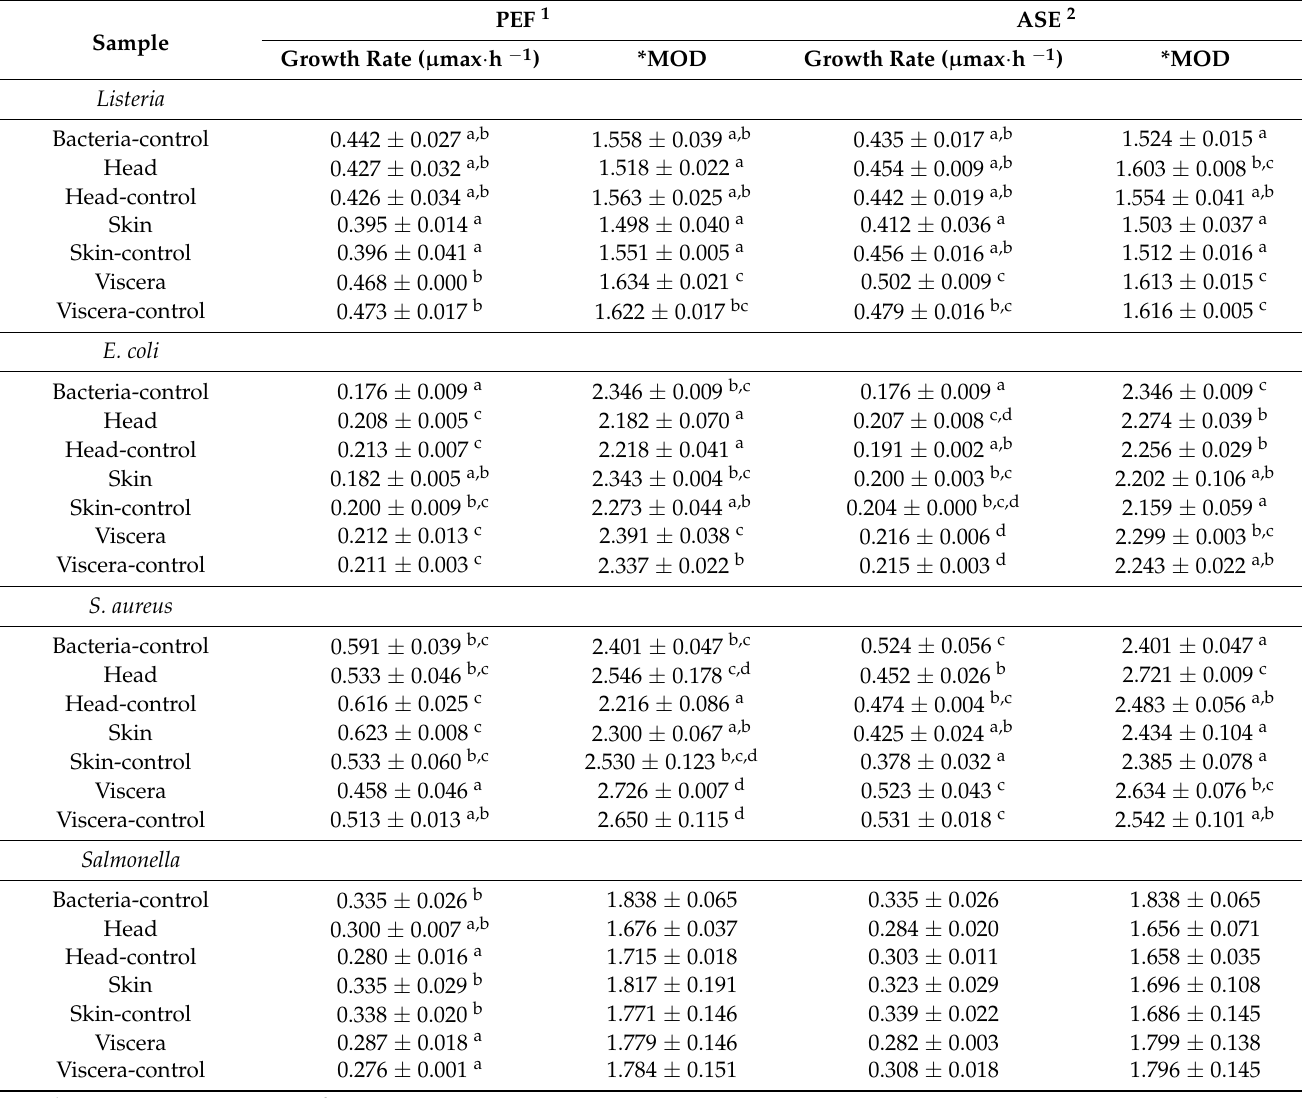
Table 4. Effect of the sole extracts on the growth rate and maximal optical density of four pathogenic bacteria strains.